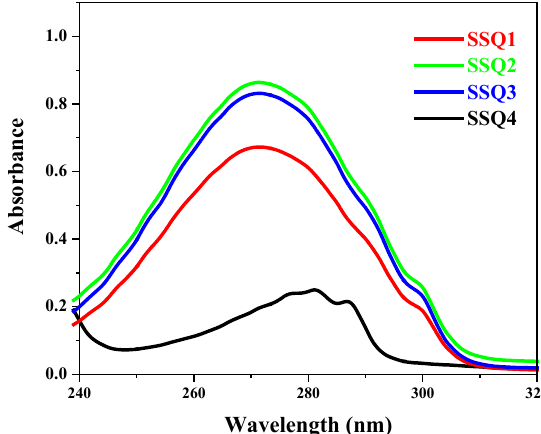
Figure 5. UV spectra of synthesized silsesquioxanes.